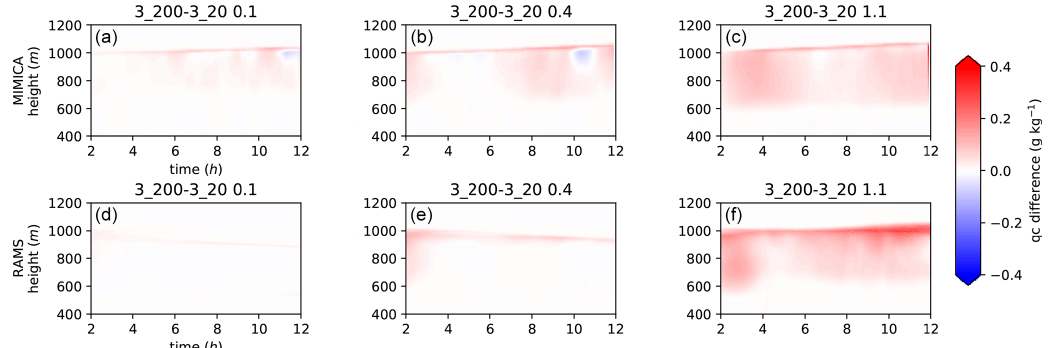
Figure 13. Differences in cloud droplet mixing ratio (qc) for simulation pairs with the same accumulation mode concentration and the same κ value of the Aitken mode particles equal to 0.1 (a, d) , 0.4 (b, e) and 1.1 (c, f) shown for MIMICA and RAMS. The first 2h of simulations, considered as the spin-up period, are excluded. A Student’s t test with a 95% confidence level shows that the (time mean) differences are statistically significantly different for each pair of simulations. For figure clarity, the plot titles have been abbreviated; the first number refers to the accumulation mode and the second to the Aitken mode concentration in cubic centimetres, i.e. 0_20 refers to AC0_AK20.